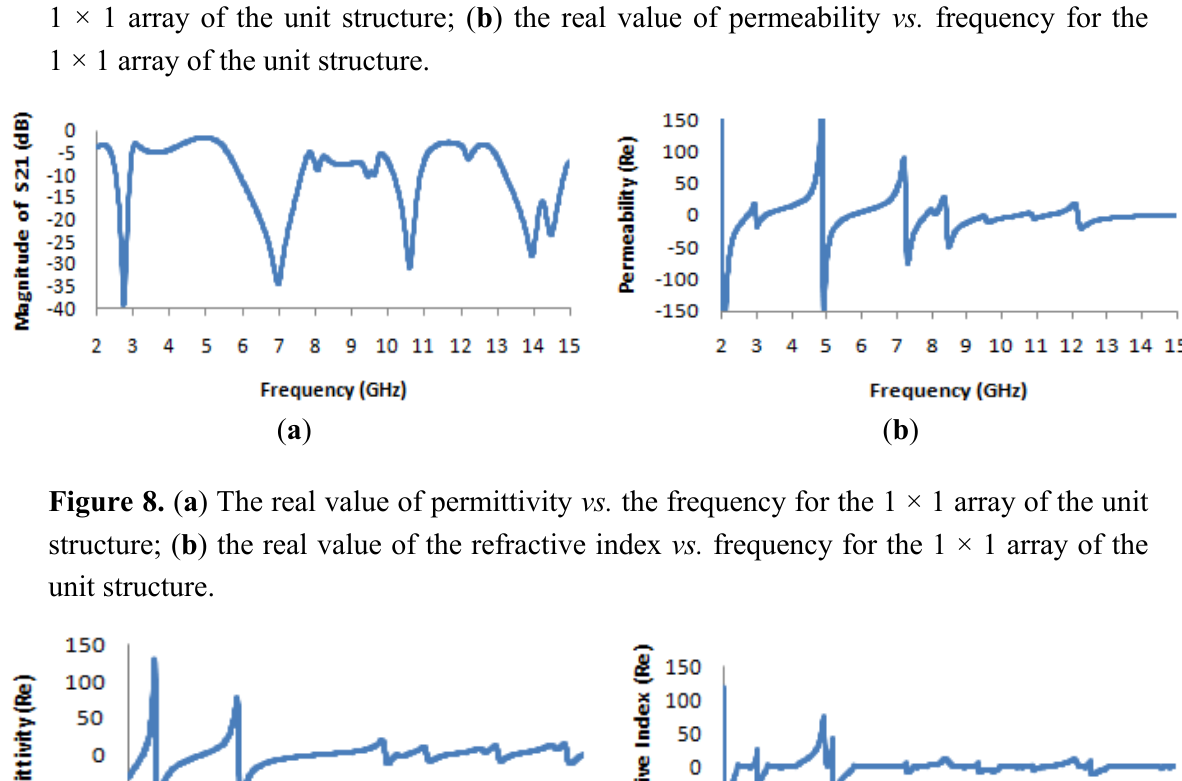
) in units of dB for the 21